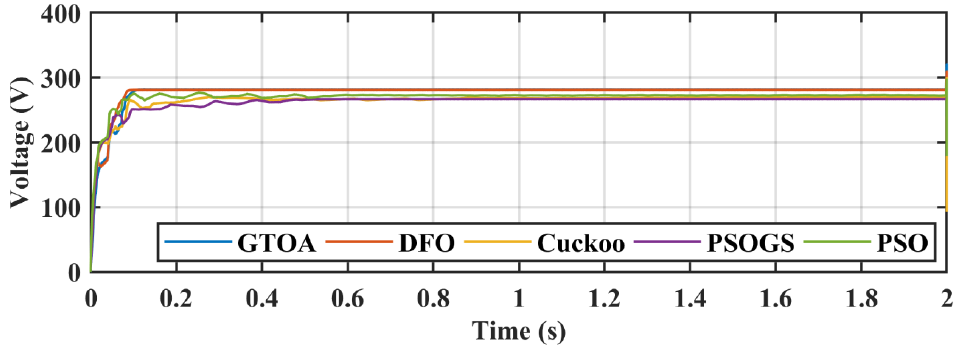
Figure 31. Comparison of voltage transients of GTOA.